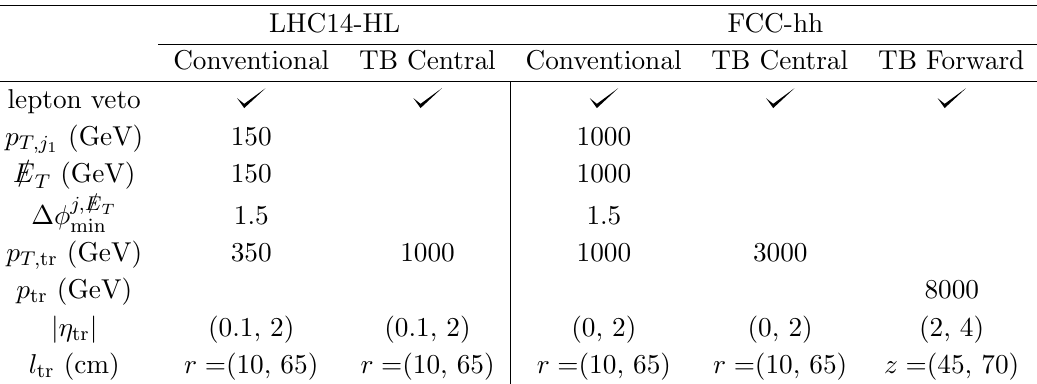
Table 1. Selection criteria for the conventional and track-based (TB) analyses presented in this paper, with p T; tr and p tr referring to the transverse and total momentum, respectively, of the charged track with length l tr . Unless otherwise noted all values given are minimum values for the quantity in